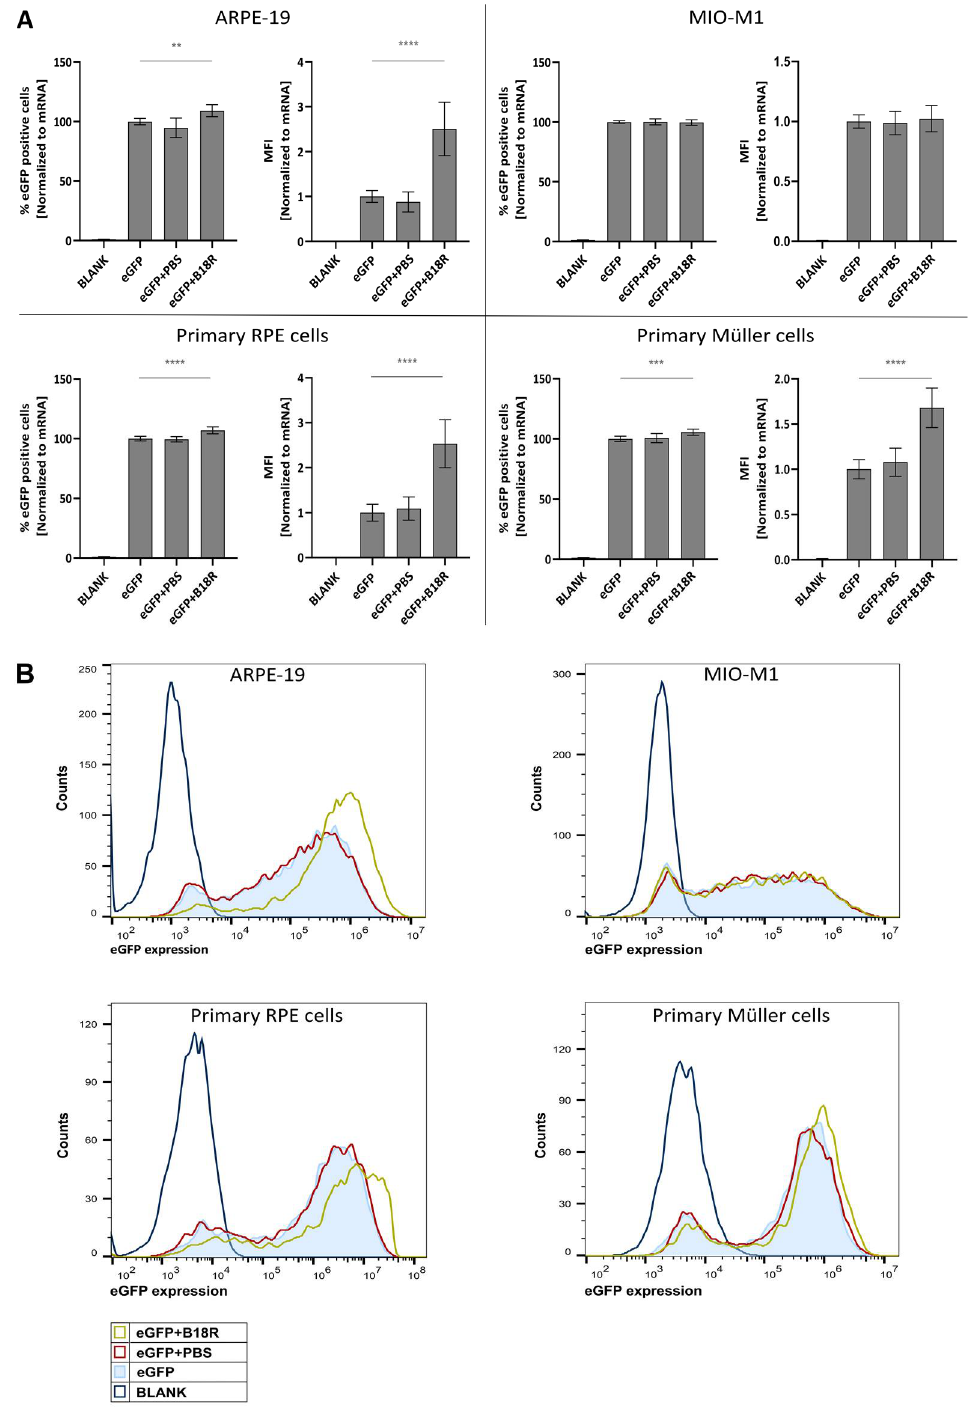
Figure 1. Transfection efficiency of mRNA-MessengerMAX lipoplexes when co-incubated with B18R. ( A ) Data are expressed as relative percentage enhanced Green Fluorescent Protein (eGFP) positive cells and relative Mean Fluorescence Intensity (MFI) both normalized to the average value of the control group which received only mRNA-MessengerMAX complexes (eGFP) (n = 3 × 3). Other samples represent untreated cells (Blank) or cells co-incubated with Phosphate-Buffered Saline (eGFP + PBS) or B18R (eGFP + B18R) during transfection. Mean absolute % of eGFP positive cells for the control group was 81%, 85%, 85% and 79% for the ARPE-19 cells, MIO-M1 cells, primary bovine RPE cells and primary bovine Müller cells respectively (** p < 0.01; *** p < 0.001; **** p < 0.0001). ( B ) Data represented as histograms obtained by flow cytometry.